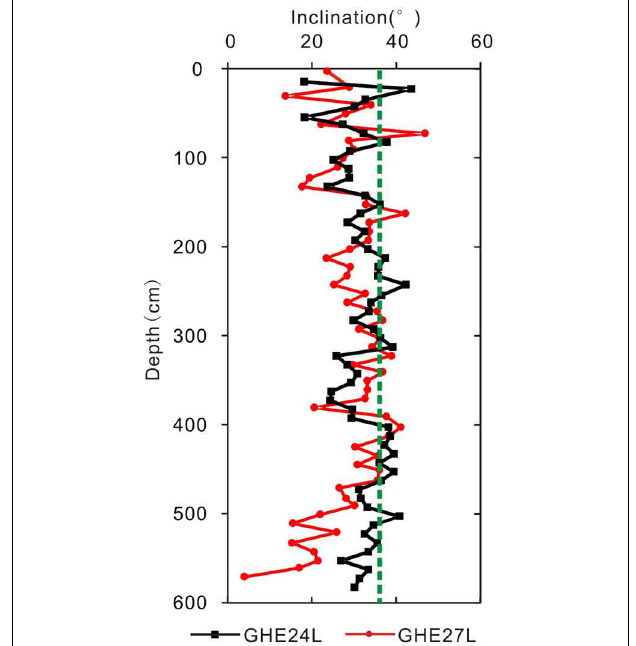
FIGURE 9 | Down-core changes in the inclinations of the ChRMs of sediments from Cores GHE24L and GHE27L, showing a similar pattern of variation except the lower part of GHE27L where inclinations are markedly shallow. The green dashed line indicates the expected inclination of the GAD field at the